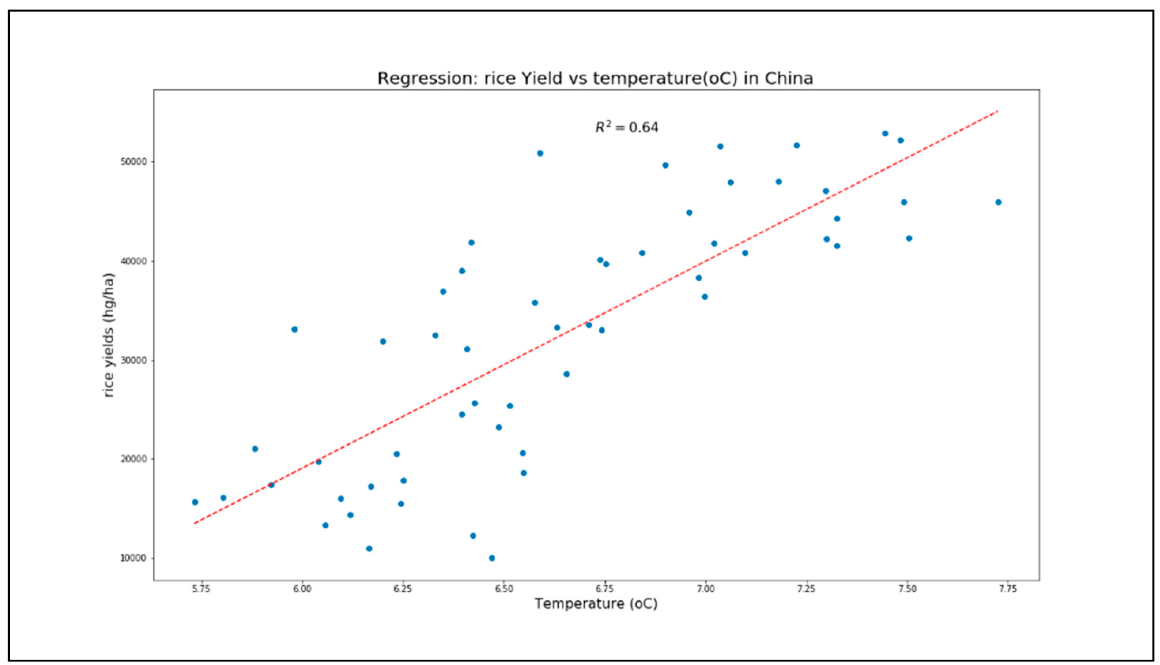
Figure 4. Crop yield—Rice vs. temperature (in °C) in China.